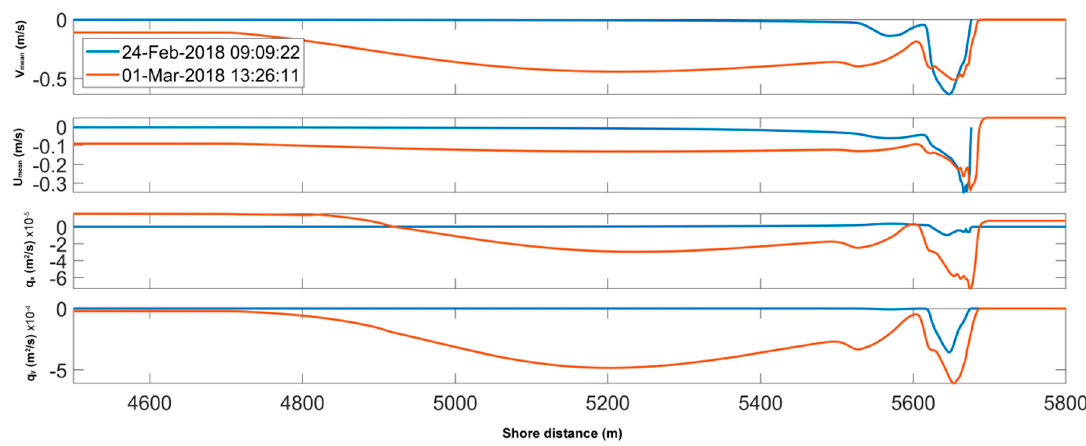
Figure 9. Comparison of cross shore variation of sediment transport and hydrodynamic conditions during non-storm conditions (24/02/18) and during the peak of the storm (01/03/18).